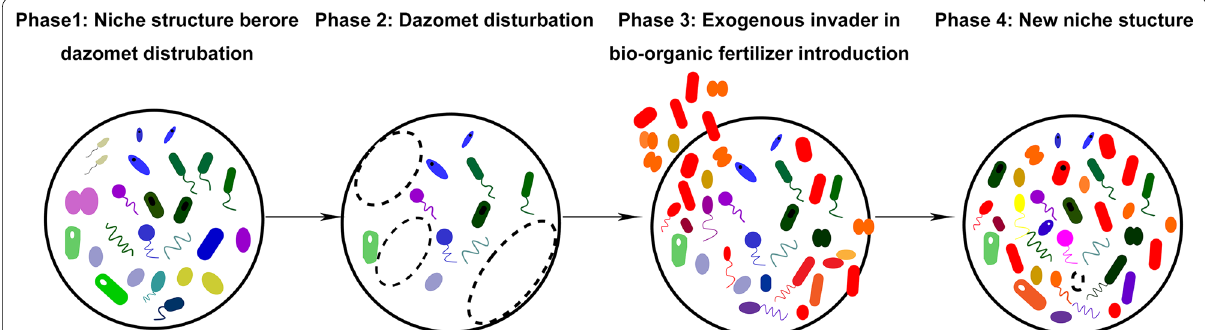
Fig. 5 A conceptual model for understanding fumigation followed by biological organic fertilizer impacts on soil resident microbial community. Consider a microbial community of resident soil as a circle, as shown in ( a ). When dazomet is applied into the soil, the niches in resident soil are released ( b ). The introduced species in biological organic fertilizer will take up the niches ( c ) and alter the niche structure in such way ( d